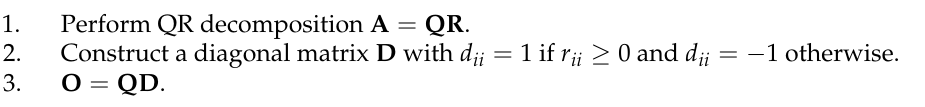
Algorithm 1 Constructing a random orthogonal matrix from the Haar